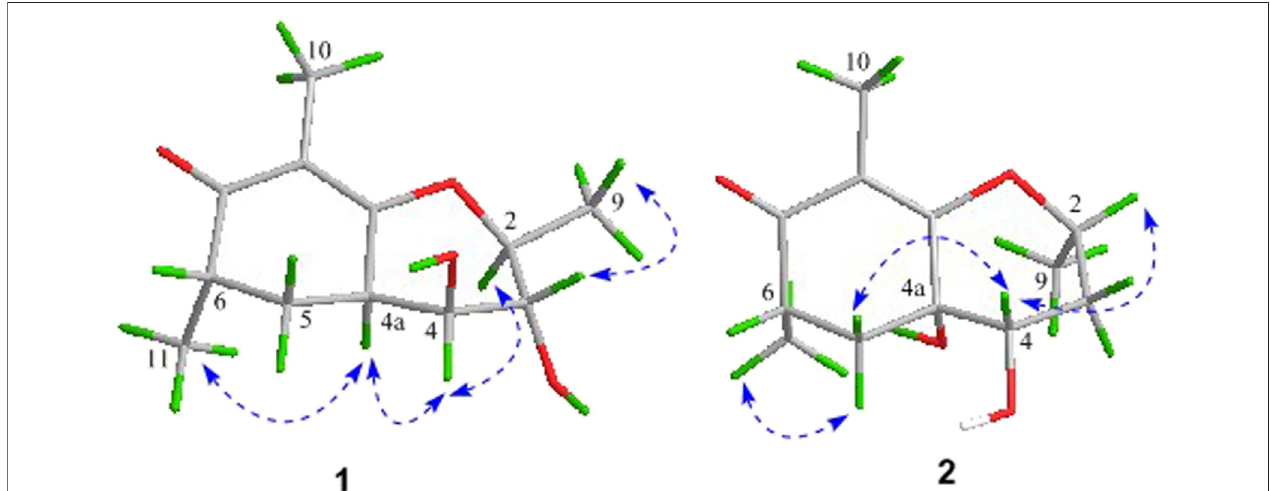
FIGURE 3 | Key NOESY correlations of compounds 1 and 2.